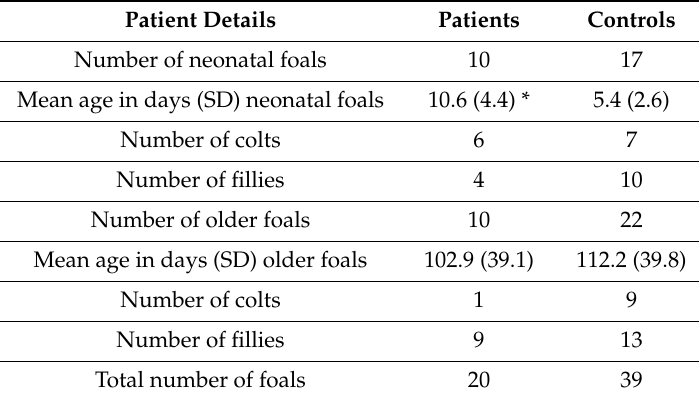
Table 1. Data of foals that were included in the study ( n = 59).